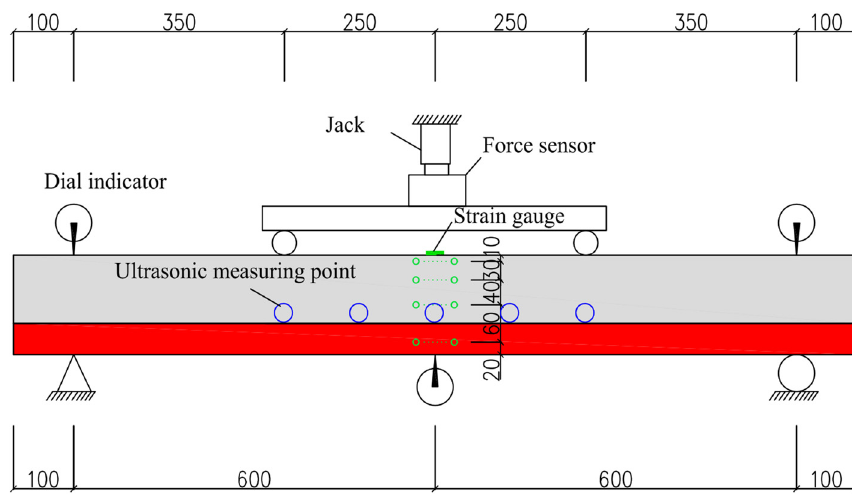
Figure 4: Illustrative diagram of beam bending behavior test of repaired